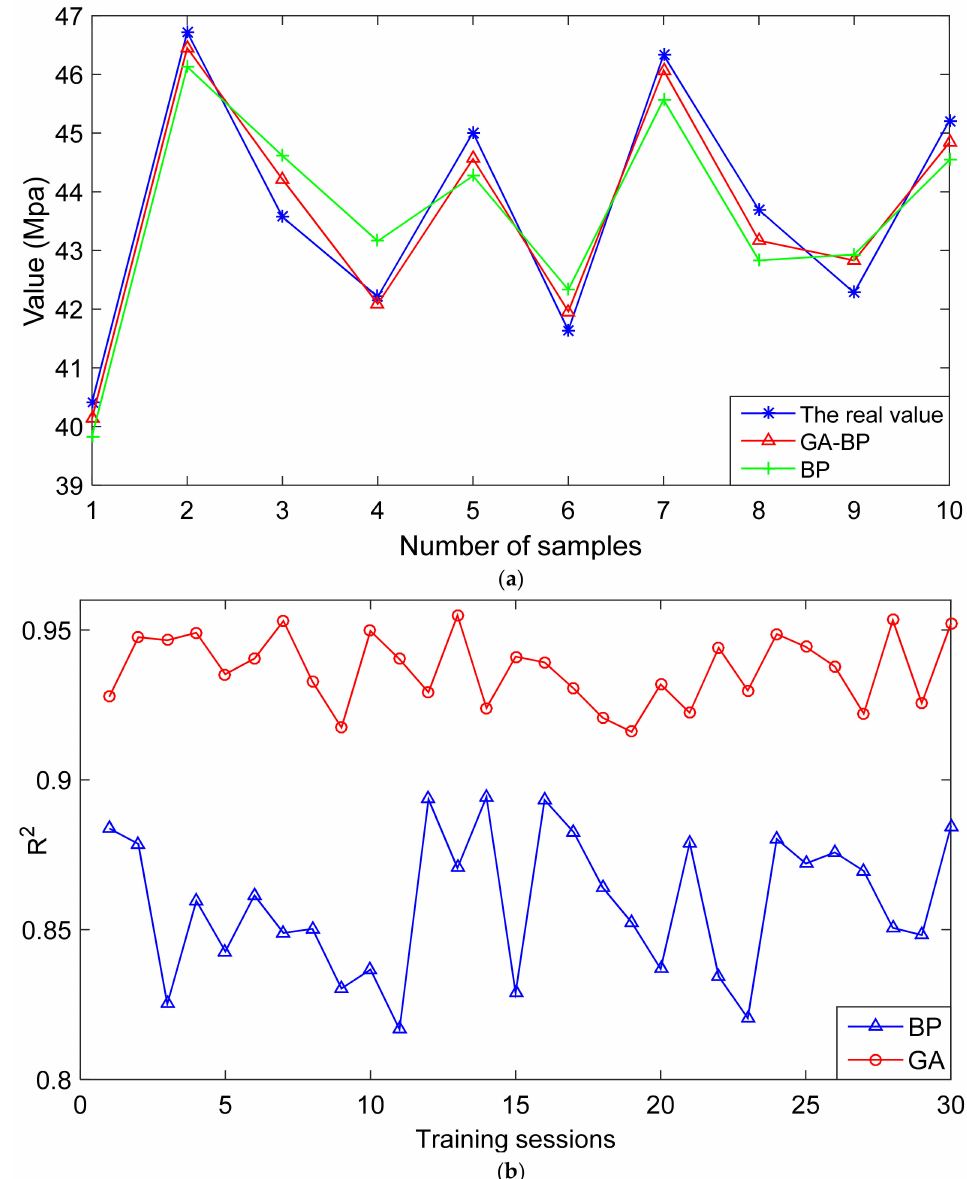
Figure 6. Comparison of the first roof weighting strength results. ( a ) The value of the first roof weighting strength predicted by the BP and GA-BP prediction models; ( b ) a comparison of the determination coe ffi cients predicted by the BP and GA-BP